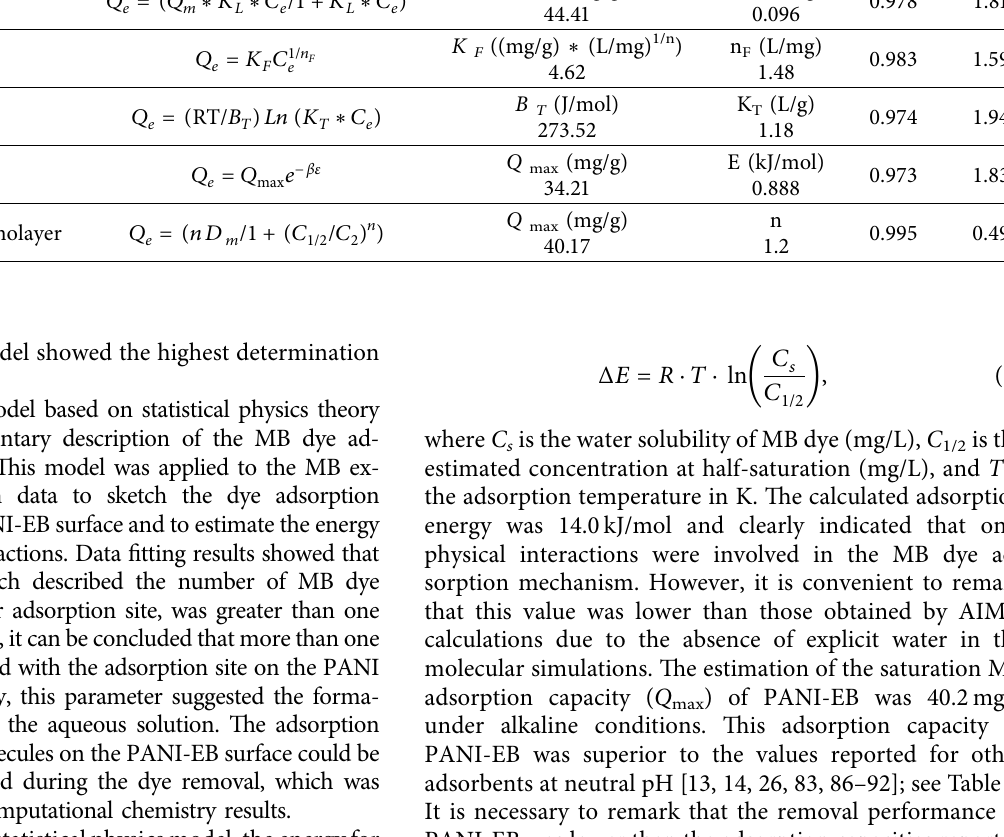
Figure 12: Isotherm of MB adsorption on PANI-EB, at pH 8 and 30 ° C, and its correlation with (a) Langmuir and Freundlich, (b) Temkin and statistical physics monolayer, and (c) Dubinin-Radushkevich Table 6: Parameters of isotherm models for the MB adsorption on PANI-EB powder at pH 8 and 30 ° C. Isotherm model Equation R 2 RMSE Langmuir